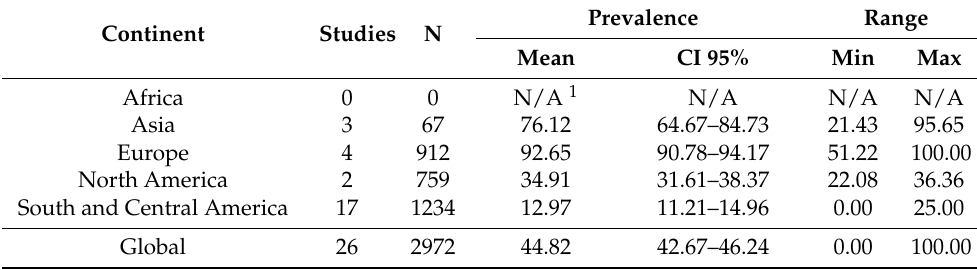
Table A8. Flock SLRV prevalence in each continent from 2001 to 2010.